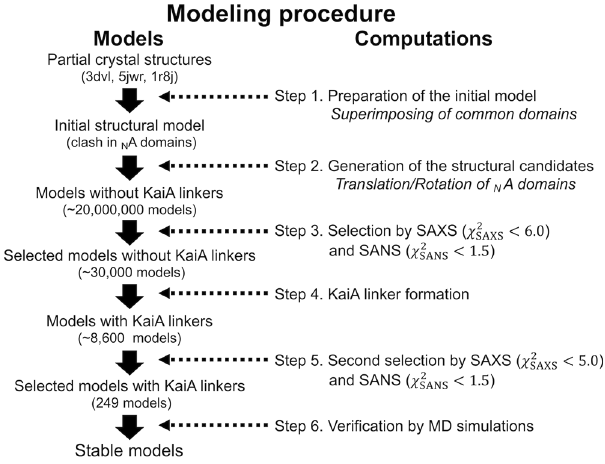
Fig. 2 Modeling procedure of the overall structure of A 12 B 6 C 6 complex. Left column denotes the structural models and right one does step-by-step computational